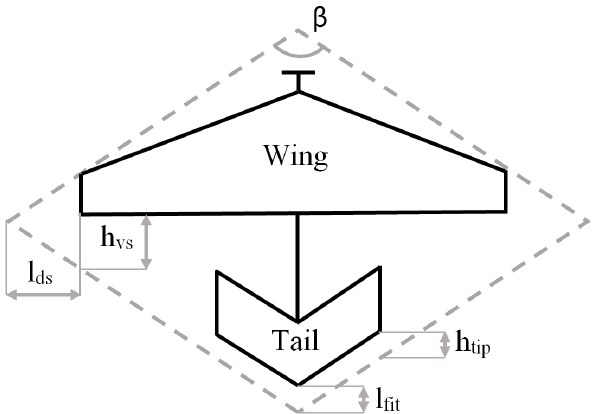
Figure 14. General configuration for the rhombus box model